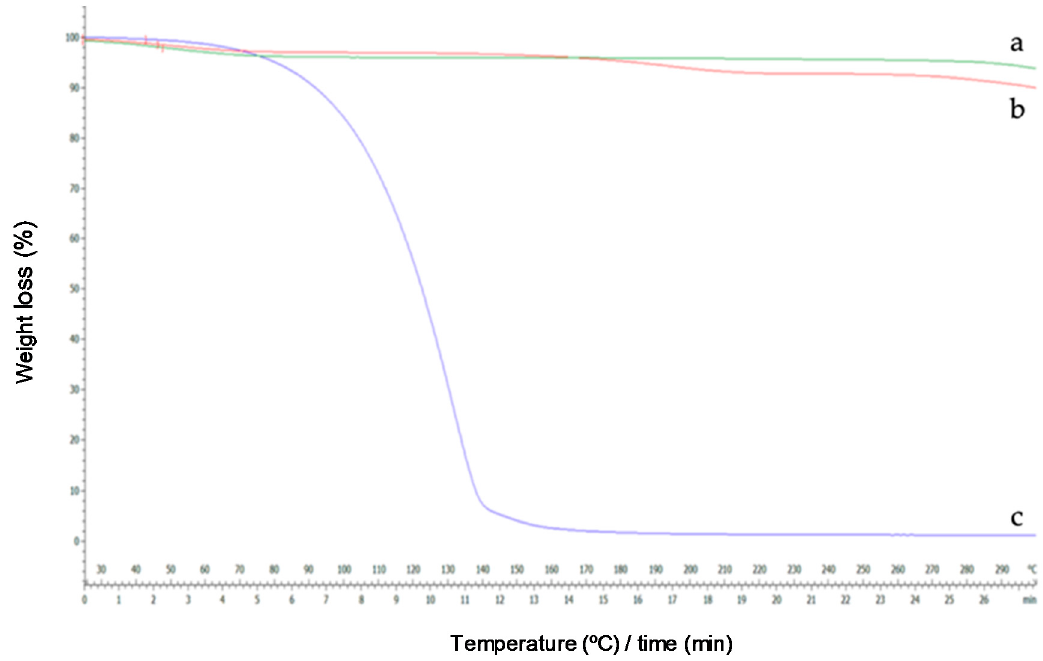
Figure 9. Thermograms of HP- β -CDs ( a ), linalool-HP- β -CDs complexes by US ( b ), linalool ( c ).